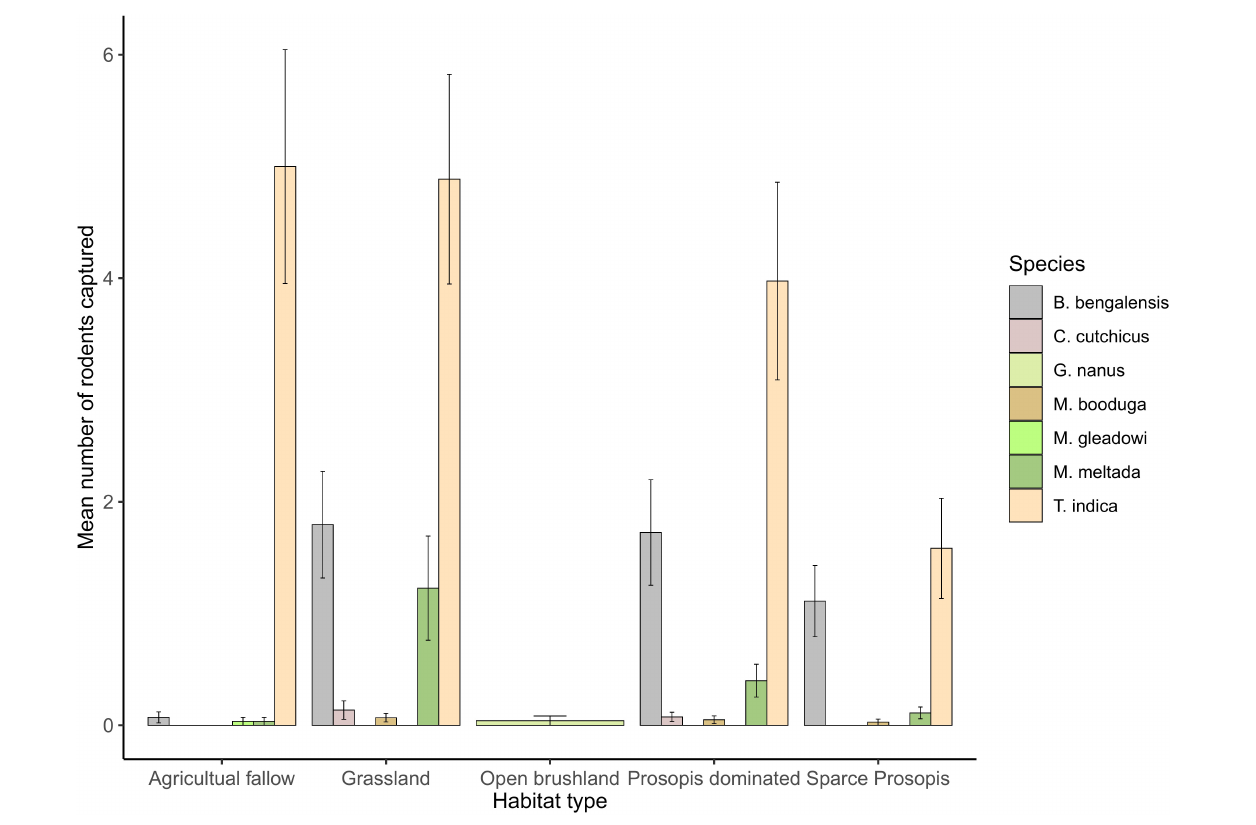
FIGURE 2 | Species composition of rodents in different habitat types based on per night captures. Note that grassland and Prosopis-dominated habitats show similar species composition.